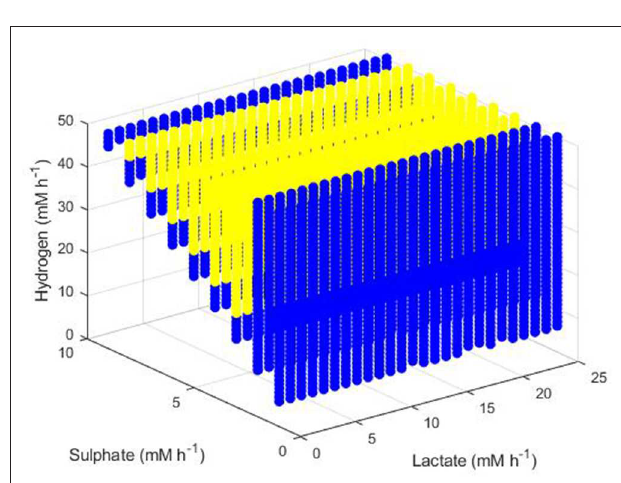
FIGURE 11 | Dilution rates under which the outcome of the model was survival of the SRB and the methanogen. The axes indicate the inflow rate of each of the three substrates. Yellow points indicate conditions where coexistence was possible at both 0.01 and 0.02 h − 1 dilution rates and blue points indicate conditions where coexistence was only possible at a dilution rate of 0.02 h − 1